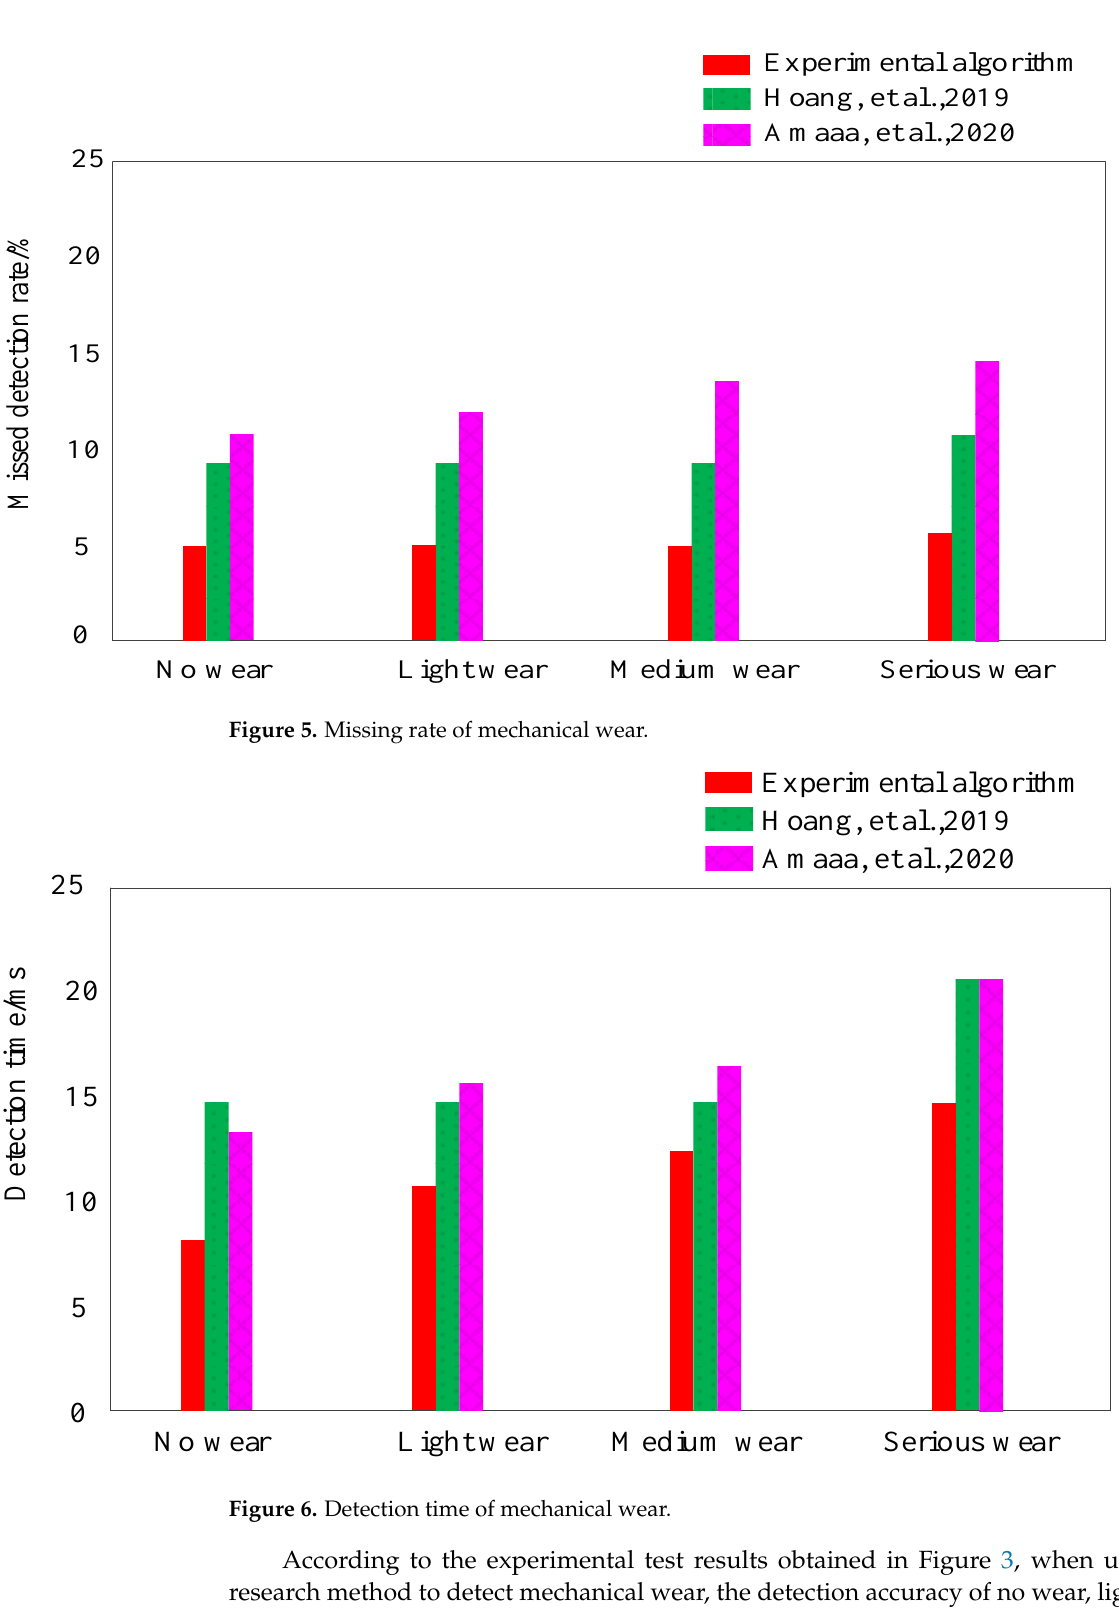
Figure 4. False detection rate of mechanical wear.